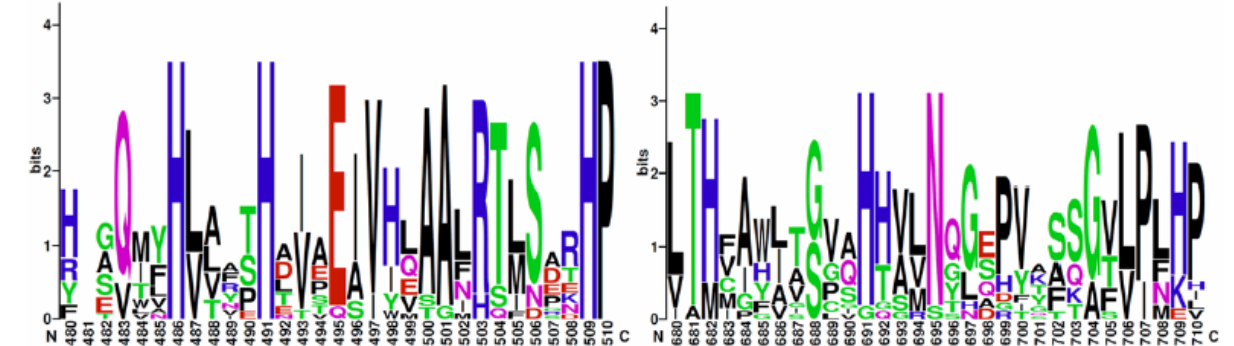
Figure 7. Sequence logos of putative metal-ligand binding sites of manganese lipoxygenases. Using the known structure of manganese lipoxygenase from Magnaporthe oryzae [67] as a guide, the metal-ligand binding residues in the multiple sequence alignment are located at H486, H491, H691, and N695. The three manganese lipoxygenase proteins identified in this study had the same residues. The sequence XM_007913037.1 from Togninia minima had a glycine and a serine at positions 691 and 695, respectively. The images were generated using WebLogo [68]. Colors represent chemical properties of amino acids: polar, green; basic, blue; acidic, red; hydrophobic, black; glutamine and asparagine are pink.